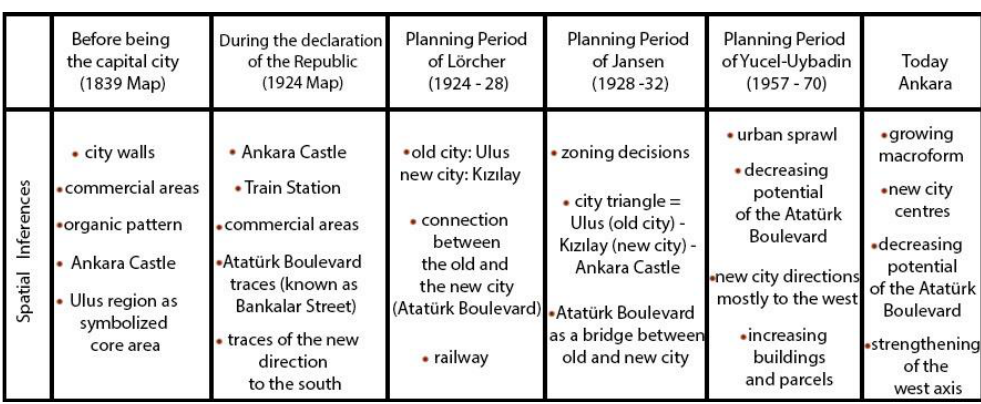
Figure 13 The spatial effects of the examined periods on the city.